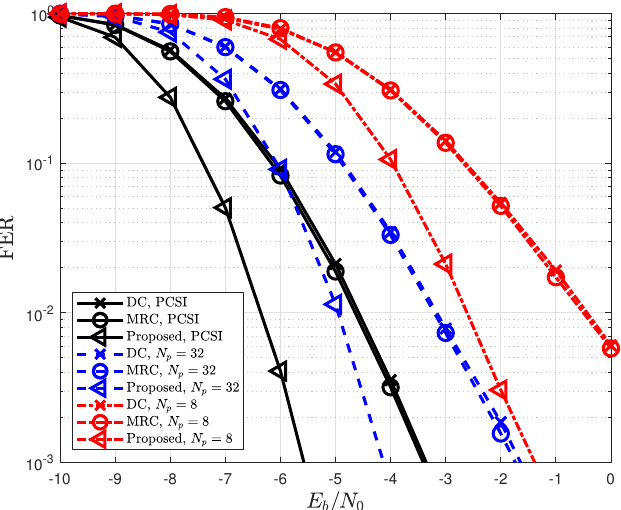
Figure 6. FER for different length of pilots N p when LMMSE channel estimation is